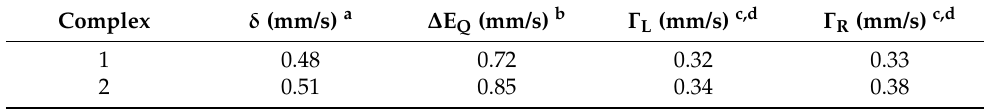
Figure 5. Mössbauer spectra from powder samples of 1 and 2 at 80 K. The black solid lines are theoretical simulations obtained with the parameters listed in Table 4. Table 4. Mössbauer parameters at 80 K for the complexes 1 – 3